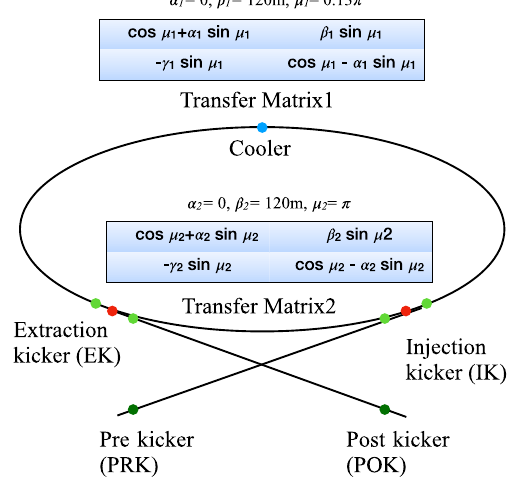
FIG. 4. Schematic view of the CCR in the ELEGANT simulation. The red dots are the injection/extraction kickers, the dark green dots are pre/post kickers, the blue dot is the cooler, and the green dots are watch points. The beam line is represented by a pair of transfer matrices shown